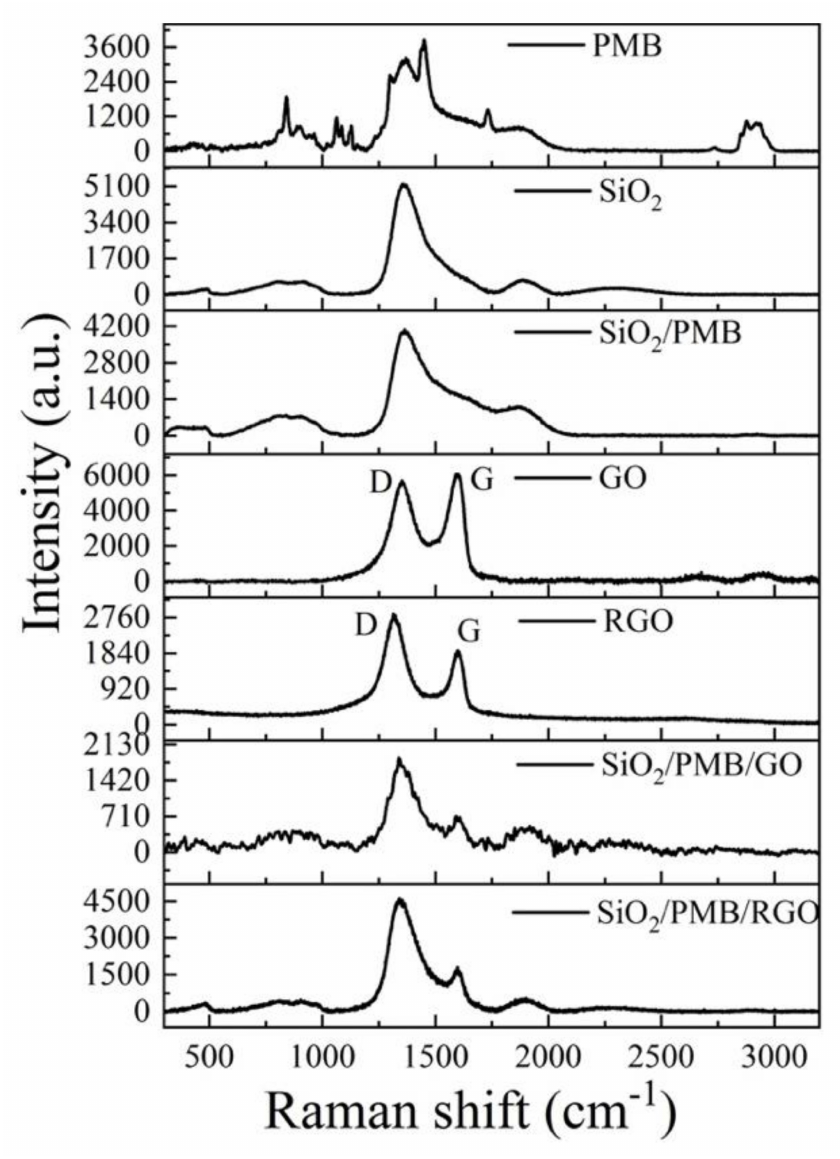
Figure 6. Raman spectrum of PMB, graphene oxide (GO), reduced graphene oxide (RGO) and photonic spray paints (PSPs) including SiO 2 , SiO 2 /PMB, SiO 2 /PMB/GO and SiO 2